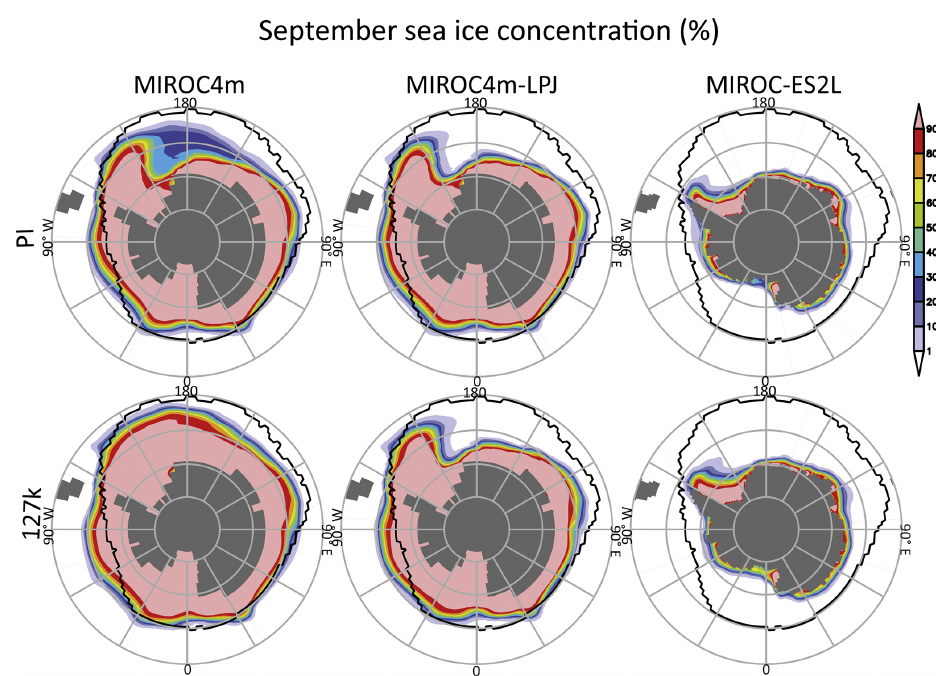
Figure 13. Same as Fig. 10 but for SH September sea ice concentration